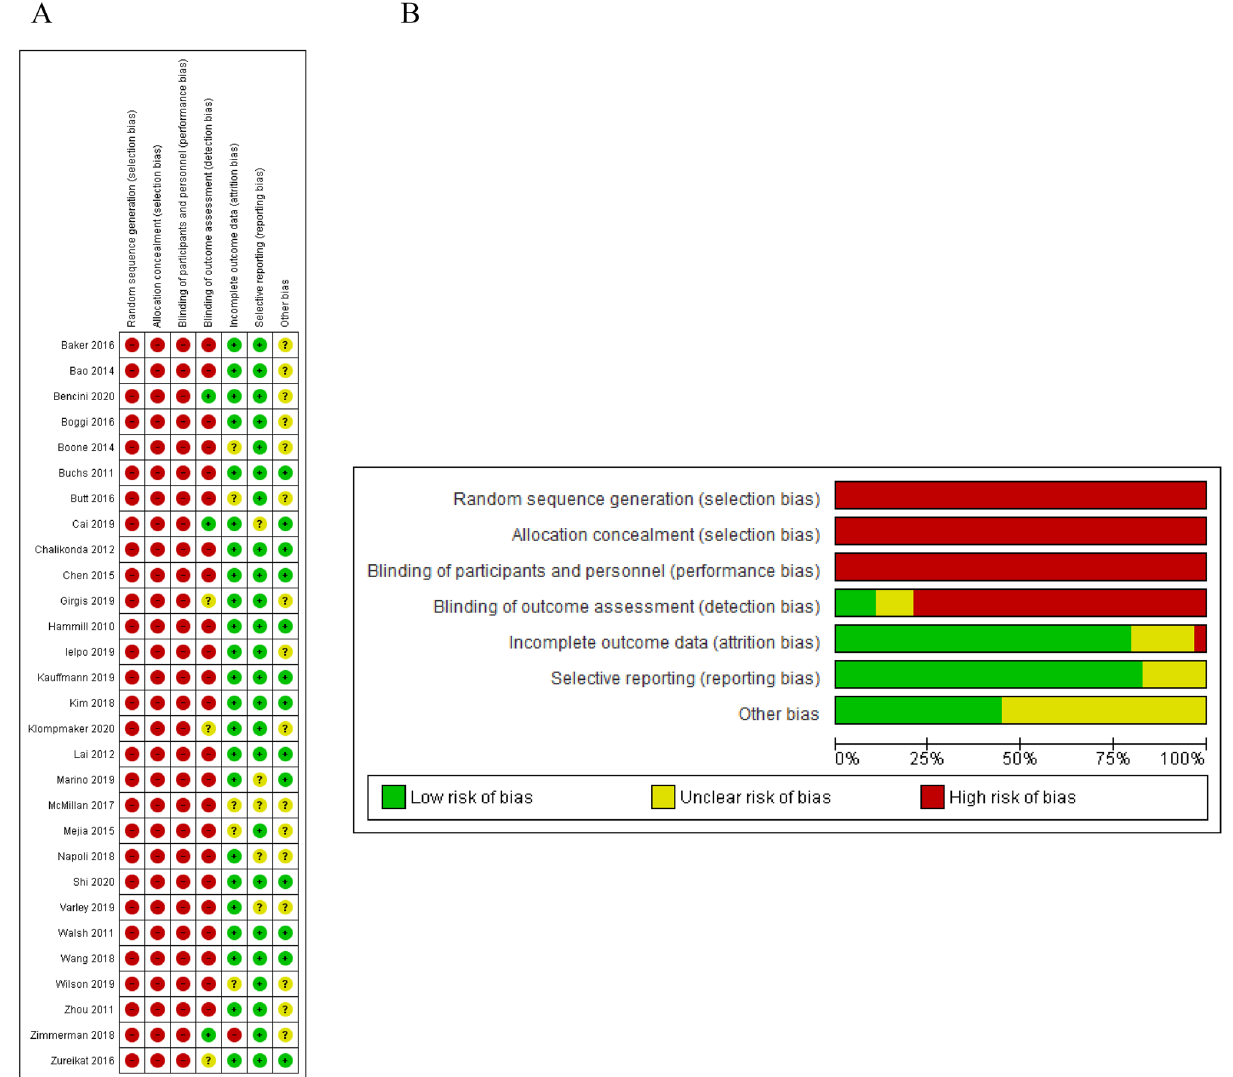
Figure 2. Quality assessment: ( A ) Risk of bias summary. ( B ) Risk of bias